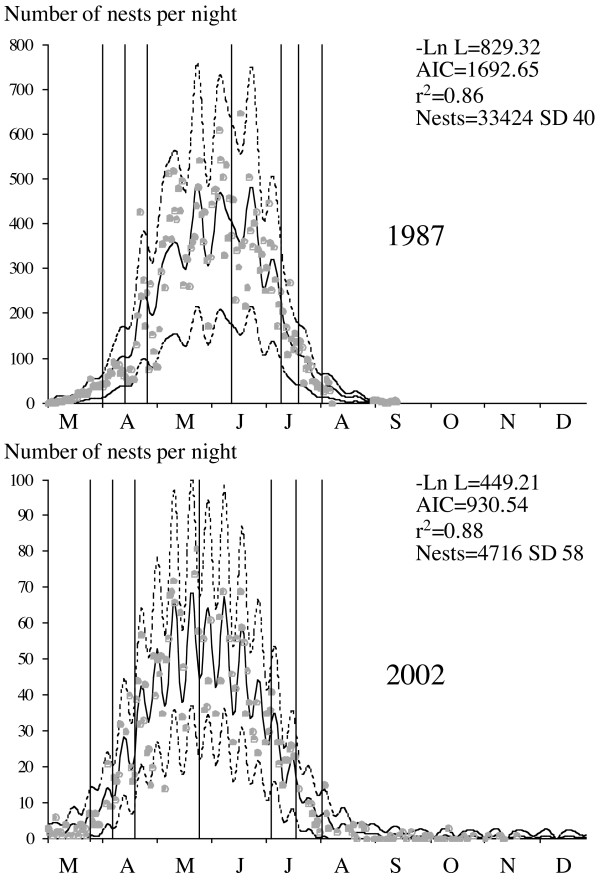
Leatherback nest distribution during the 1987 and 2002 nesting seasons in Ya:lima:po nesting beach. Black points are the nest counts. The central curve is the best fitted model and the upper and lower curves are the error envelopes (±2 SD). The vertical bars represent, from right to left, d+10%, d+25%, d+50%, day at peak, d-50%, d-25%, d-10% values (see text). -Ln L is -logarithm of maximum likelihood for the corresponding model and AIC is the Akaike Information Content.